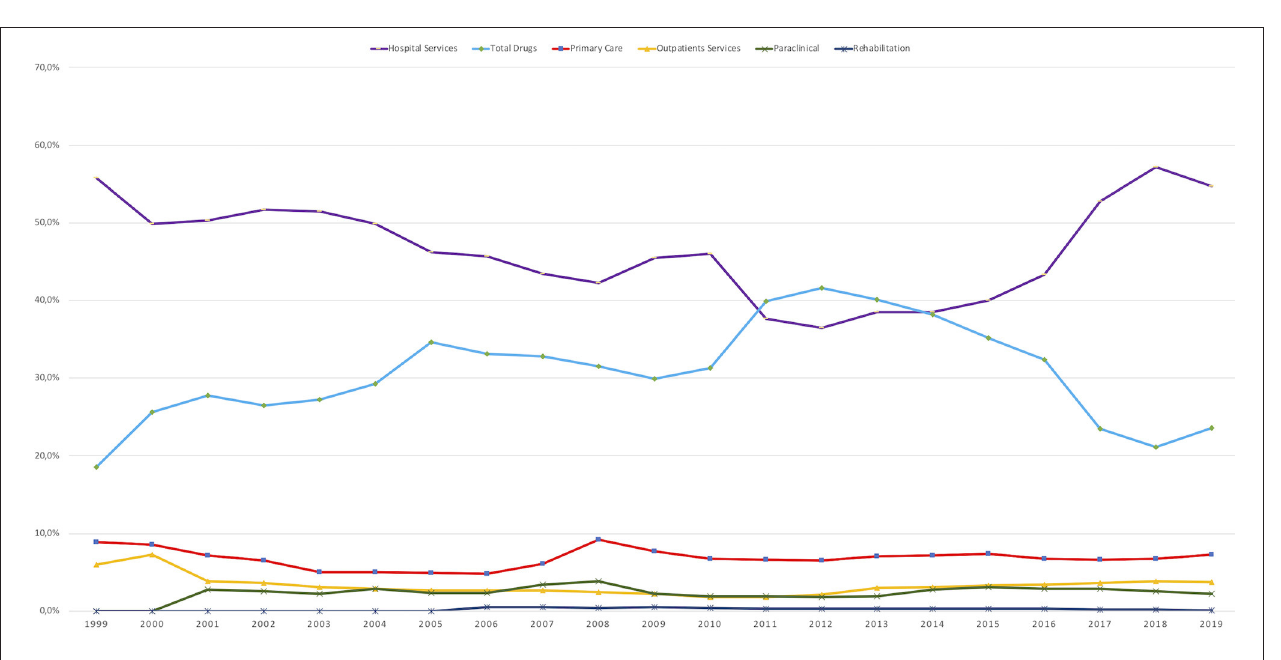
FIGURE 2 | Categories of services with stationary trends,